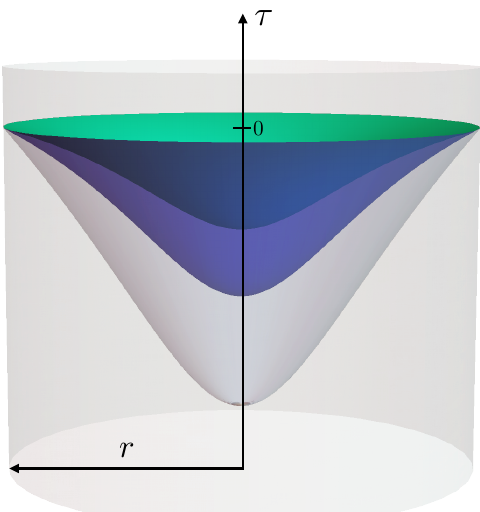
Figure 3 . Example slices Q that maximize the Hartle-Hawking wave functions in global AdS d +1 for a fixed value of T . They interpolate between the maximal, τ = 0 slice for T = 0 (green) and one reaching to τ = −∞ for T = − ( d − 1)